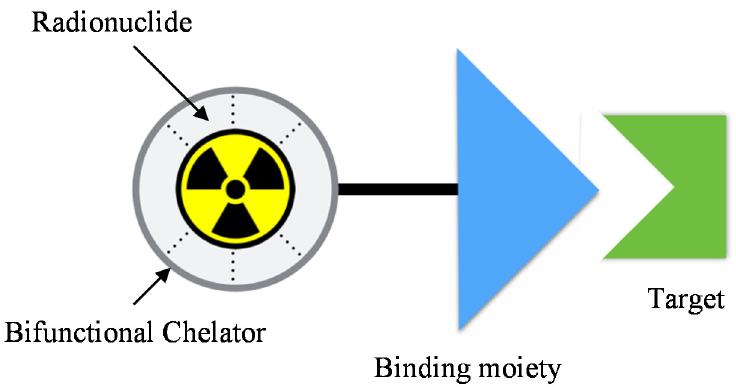
Figure 1. The design of a target mediated radiopharmaceutical consists of a radionuclide complexed to a bifunctional chelator via a process named radiolabeling. The bifunctional chelator is covalently conjugated to a binding moiety, which acts as a vehicle for the radiopharmaceutical to bind to a specific target.